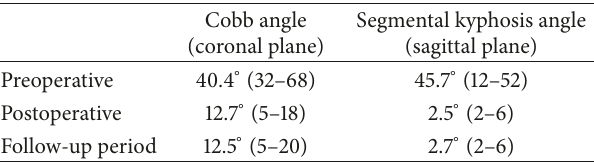
Table 1: Angular values of coronal and sagittal plane deformities preoperative, postoperative, and follow-up